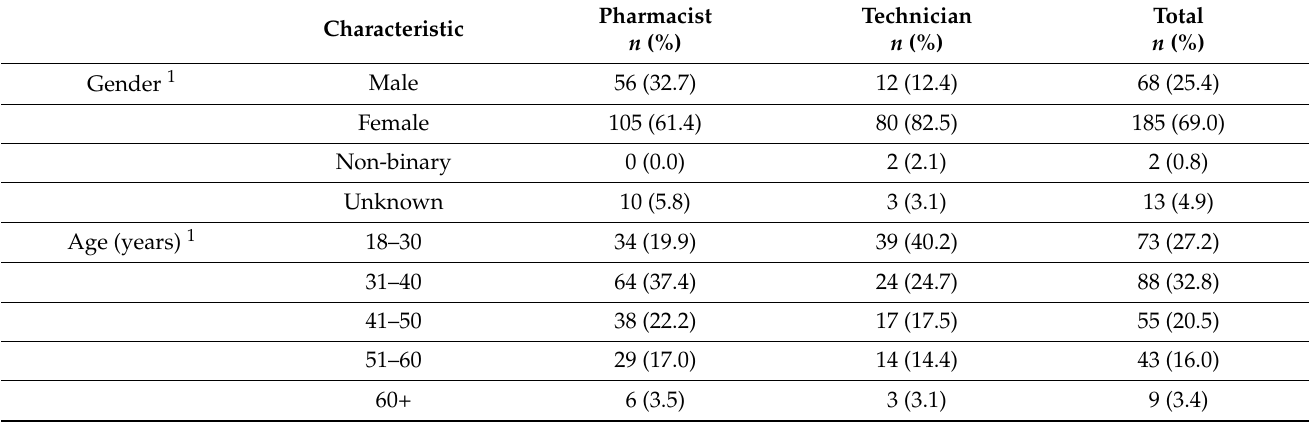
Table 1. Survey respondent